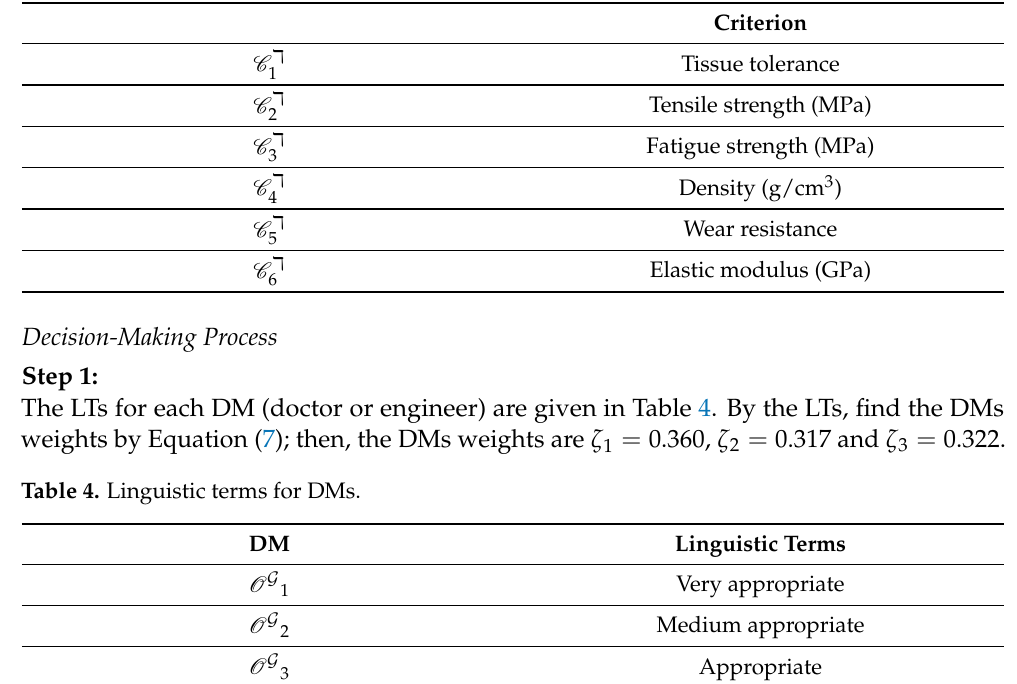
Table 3. Criterion for land selection.